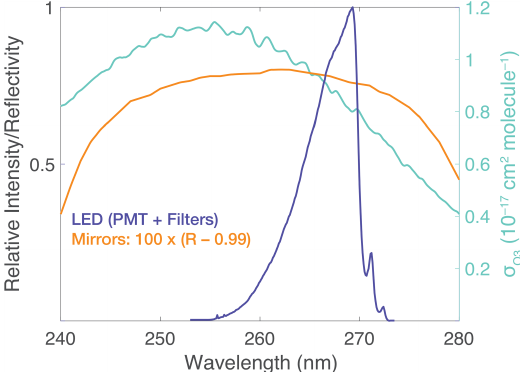
Figure 2. LED spectrum, mirror reflectivity, and O 3 absorption cross section: the LED ( λ max = 265nm, FWHM = 10nm; full width at half maximum) spectrum was measured using a grating spectrometer (0.1nm resolution) with the instrument PMT and as- sociated detector optics. The mirror curve depicts 100 × [ R − 0 . 99], where R is the reflectivity, over a range of wavelengths. The right axis shows the absorption cross section for the O 3 Hartley band. O 3 and Rayleigh cross sections were determined as the weighted av- erage with the normalized intensity of the LED and PMT detector optics.